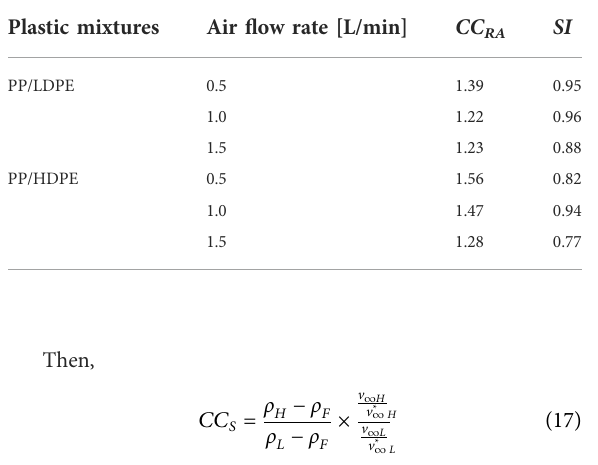
FIGURE 3 Apparent speci fi c gravities of PP, LDPE, and HDPE at different air fl ow rates (i.e., 0, 0.5, 1.0, and 1.5 L/min) in water (i.e., without wetting agent).